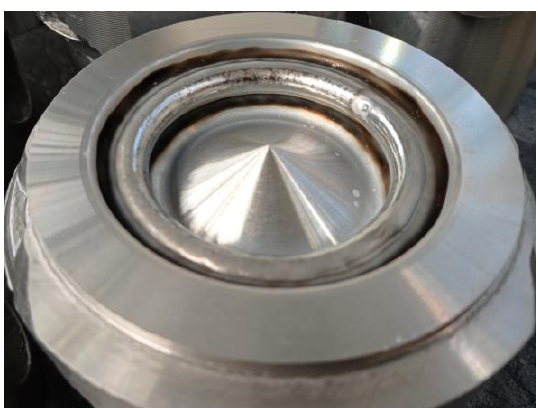
Fig. 8. Combustion chamber of an aluminum piston after the local DuralBowl remelting process